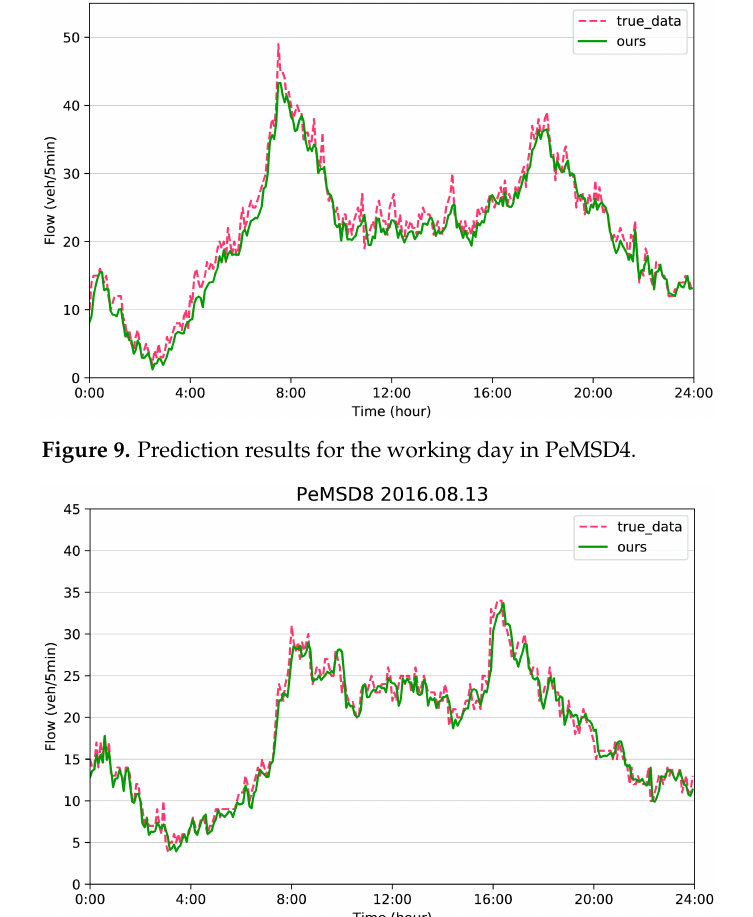
Figure 10. Prediction results for the non-working day in PeMSD8.